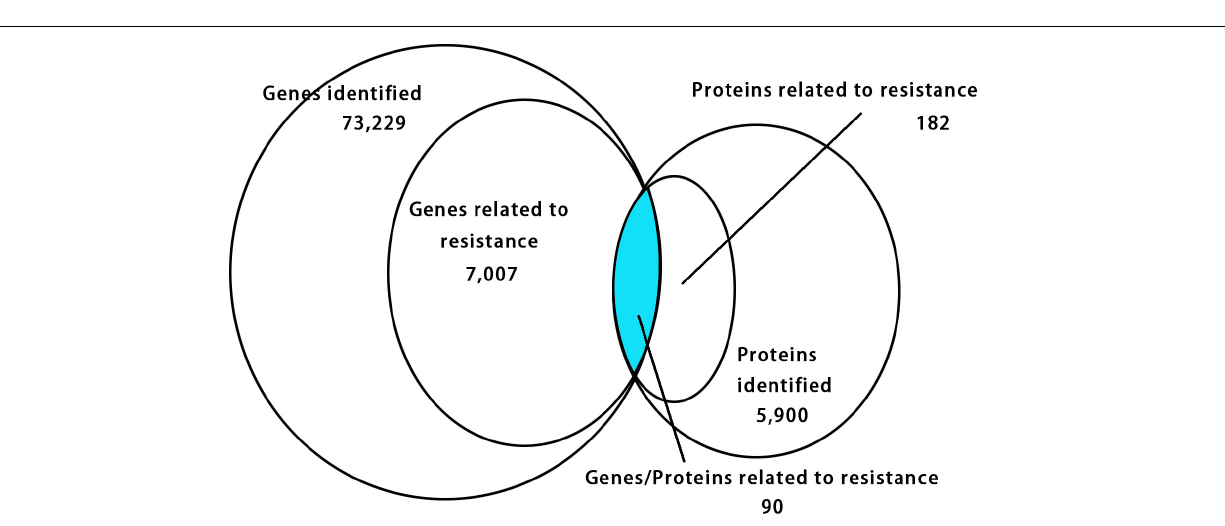
Frontiers in Physiology |